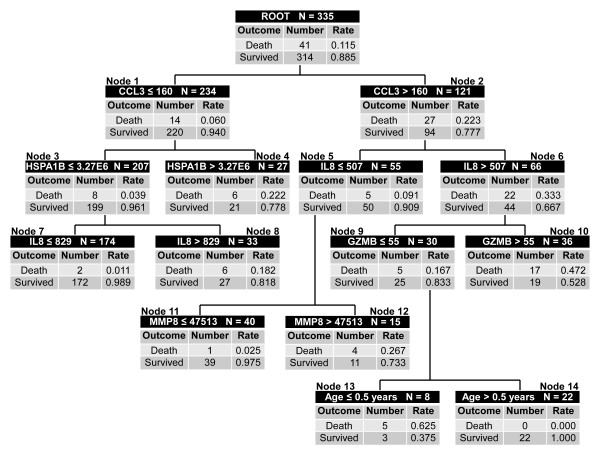
Classification tree from the updated model based on the combined derivation and test cohorts (n = 355). The classification tree consists of six biomarker-based decision rules, one age-based decision rule, and fourteen daughter nodes. The classification tree includes five of the twelve candidate stratification biomarkers: C-C chemokine ligand 3 (CCL3), heat shock protein 70 kDa 1B (HSPA1B), interleukin-8 (IL8), granzyme B (GZMB), and matrix metalloproteinase-8 (MMP8). Each node provides the total number of subjects in the node, the biomarker serum concentration- or age-based decision rule, and the number of survivors and non-survivors with the respective rates. For consistency, the serum concentrations of all stratification biomarkers are provided in pg/ml. Terminal nodes 7, 11, and 14 are considered low-risk nodes, whereas terminal nodes 4, 8, 10, 12, and 13 are considered high-risk terminal nodes. To calculate the diagnostic test characteristics, all subjects in the low risk terminal nodes (n = 236) were classified as predicted survivors, whereas all subjects in the high risk terminal nodes (n = 119) were classified as predicted non-survivors. The area under the curve (AUC) for the re-calibrated decision tree was 0.883.